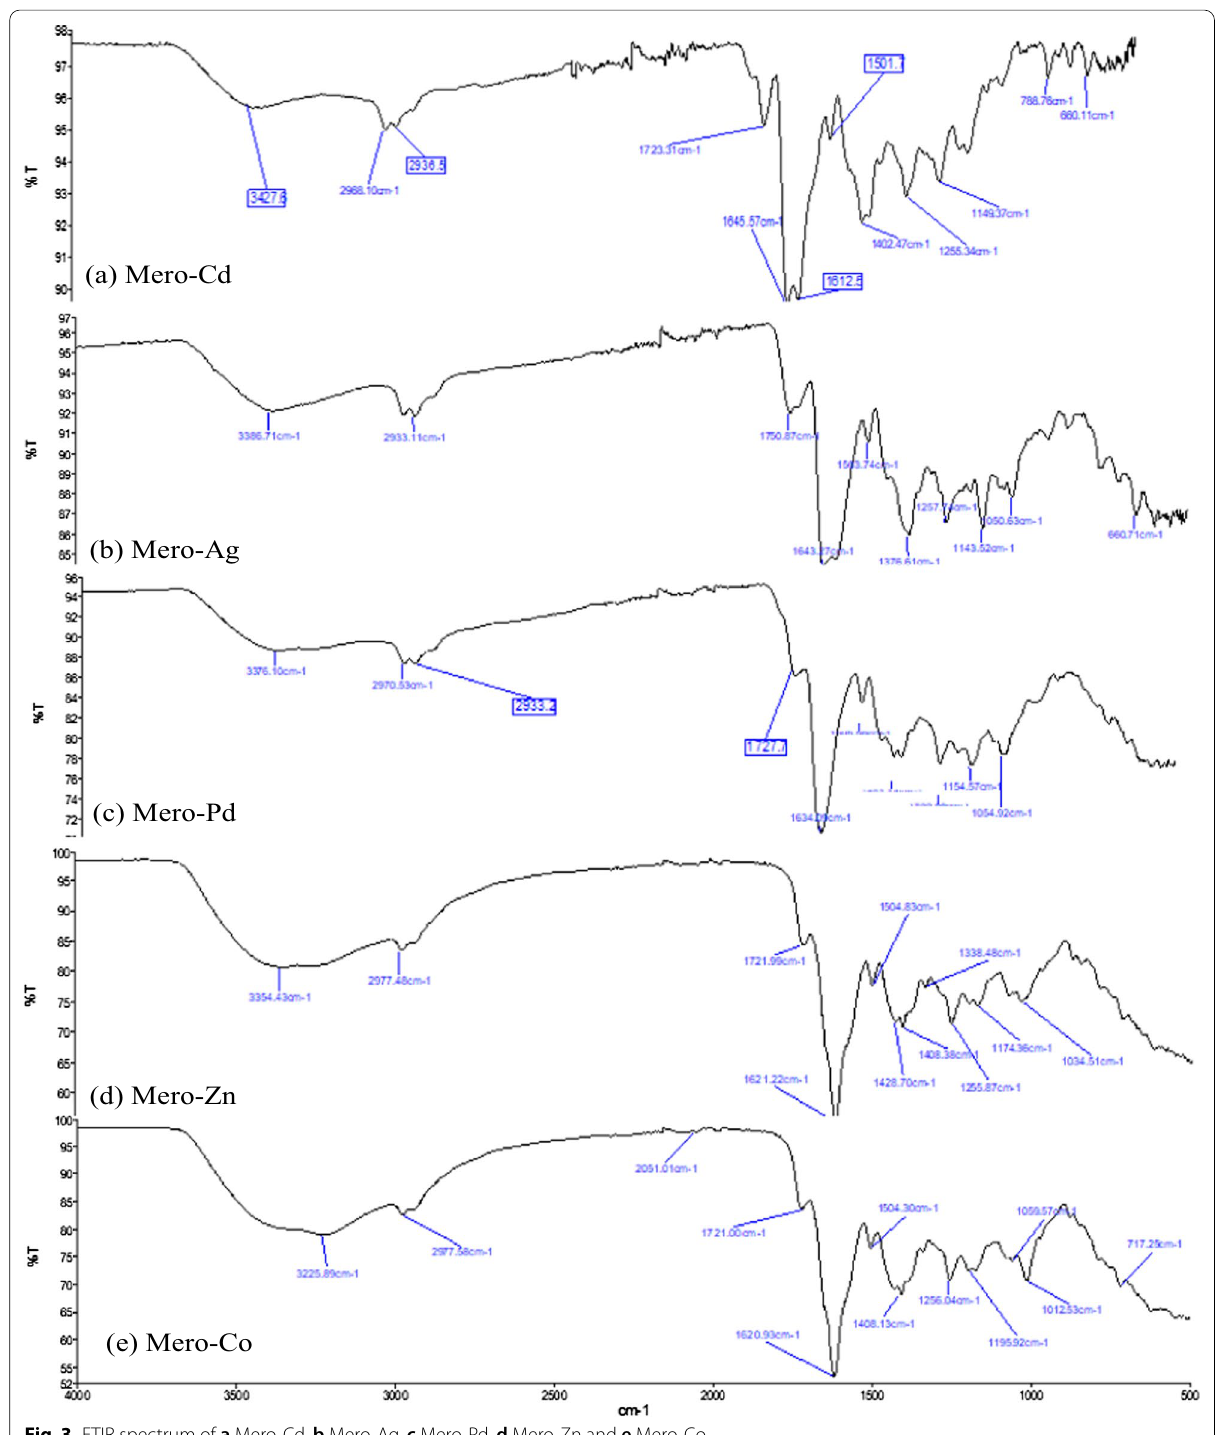
Fig. 3 FTIR spectrum of a Mero-Cd, b Mero-Ag, c Mero-Pd, d Mero-Zn and e